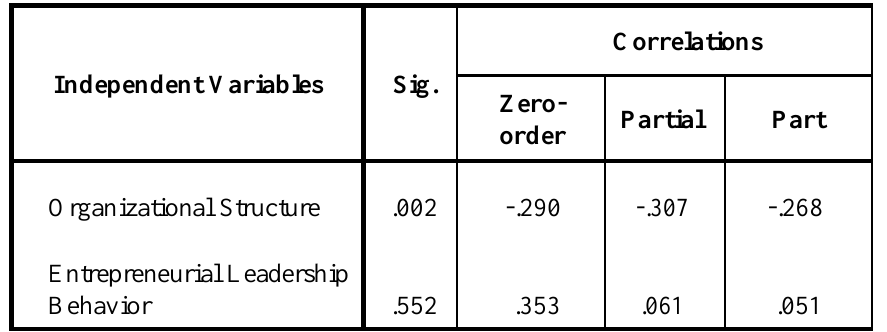
Table 09: Statement of Hypotheses and P-Values